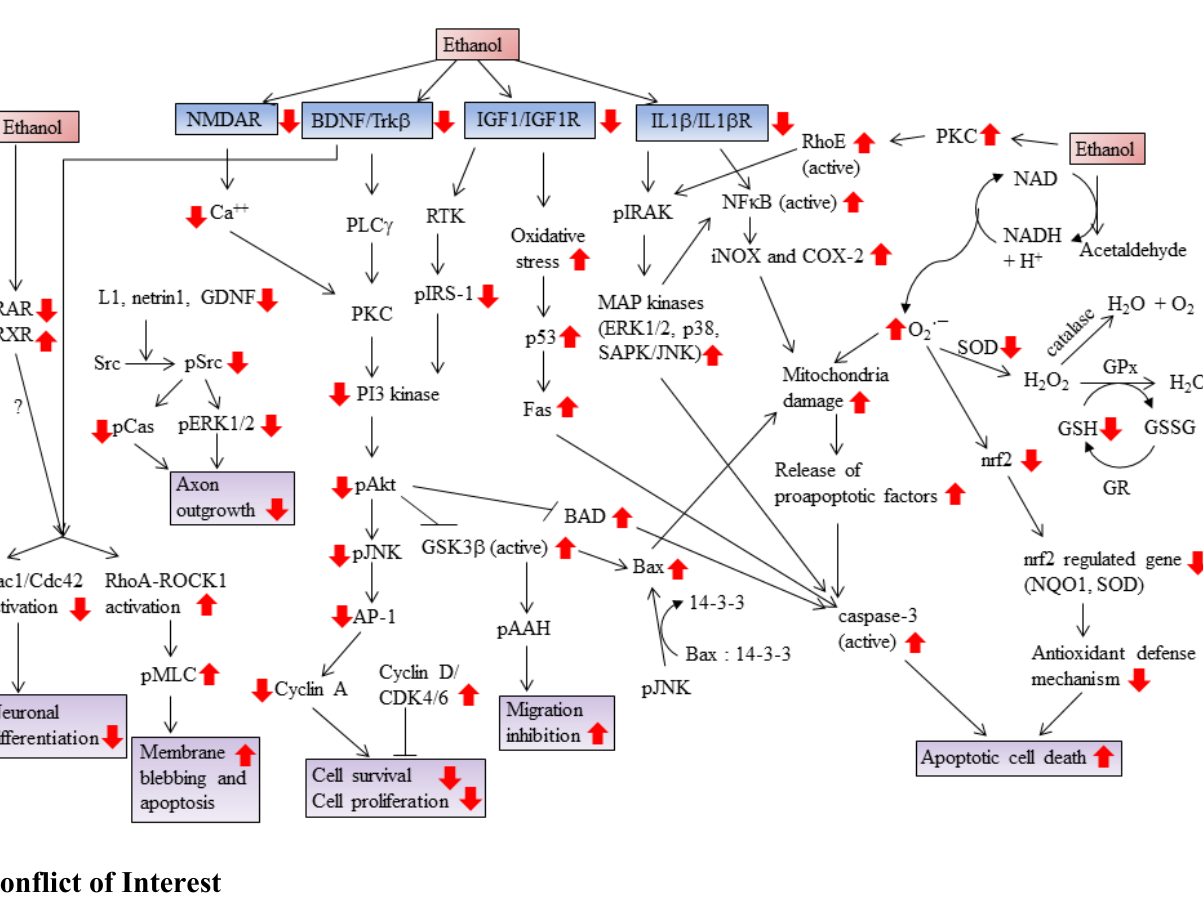
Figure 3. Ethanol-induced changes in signaling pathways/components (red colored arrow) in the developing cerebellum. Ethanol exposure inhibits axon outgrowth, cytoskeletal rearrangement, and neuronal differentiation via L1/Src/ERK1/2 pathways and RhoA and Rac1/Cdc42 activation. Ethanol also inhibits the cell proliferation by altering the levels of proteins required for cell cycle progression, e.g., increasing the levels of cyclin D/CDK4/6 and by decreasing the levels of cyclin A. Ethanol impairs NMDA, BDNF/TrkB, IGF/IGFR and IL1 β /IL1 β R-mediated pathways and their downstream signals which are required for the migration and survival of neurons. Generation of oxidative stress and reduction in the level of enzymes required for the removal of free radicals by ethanol damages mitochondria and initiates cell death in